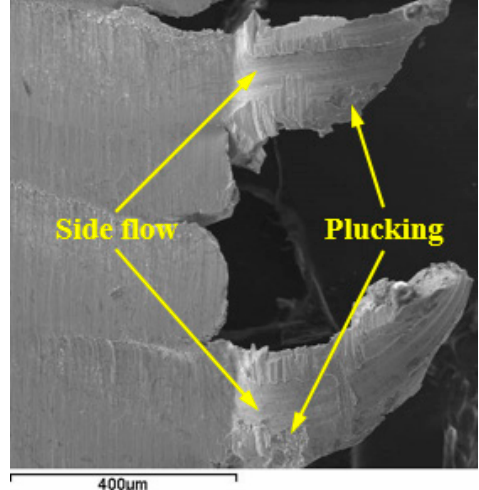
Figure 11. Side flow of chip at cutting speed of 200 m/min.